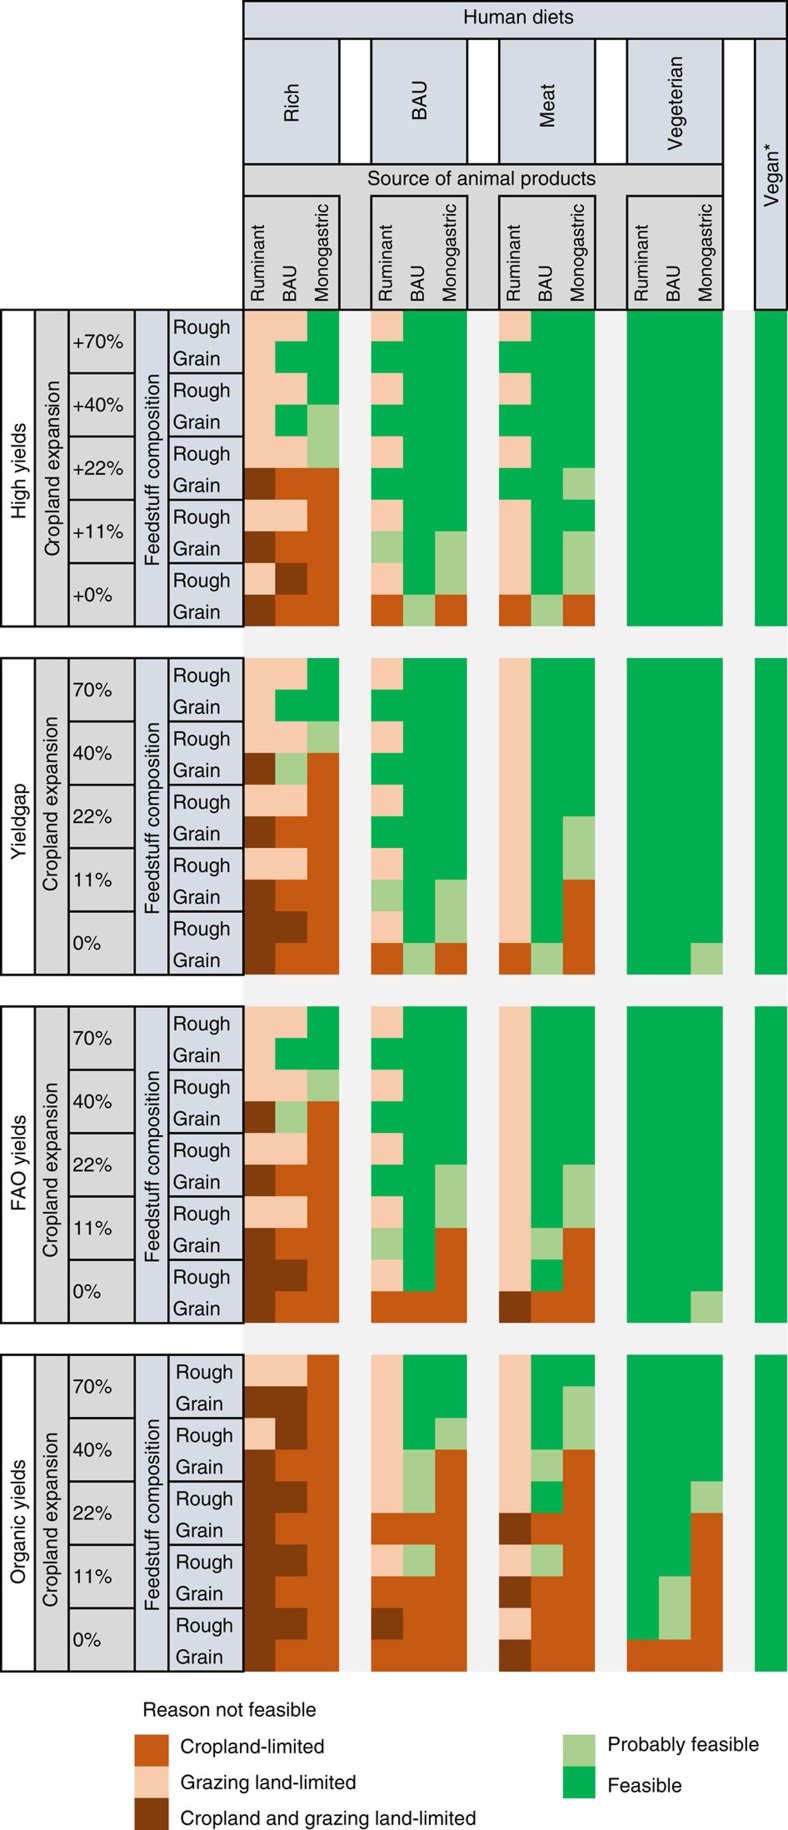
The biophysical option space in 2050.The option space (green cells) results from the combination of four yield variants, five cropland expansion variants, two variants of the feed basis for livestock at the supply side (lines) and five human diet variants combined with three variants of the origin of livestock products at the demand side (columns). Each cell in the option space represents a scenario. Scenarios affected by cropland limitations represent cases where the global demand for cropland products exceeds global supply by more than 5% and scenarios affected by grazing limitations when global grazing intensity exceeds ecological thresholds. ‘Probably feasible' are scenarios for which demand and supply differ by <5%. *For the VEGAN diet, the source of livestock products is not relevant.